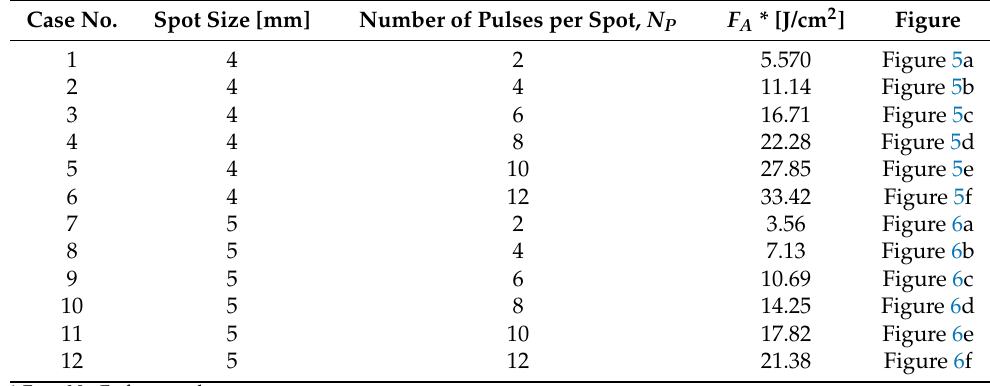
Table A1. Laser processing parameters used for the spot-by-spot method (average power 3.5 W). Case No.